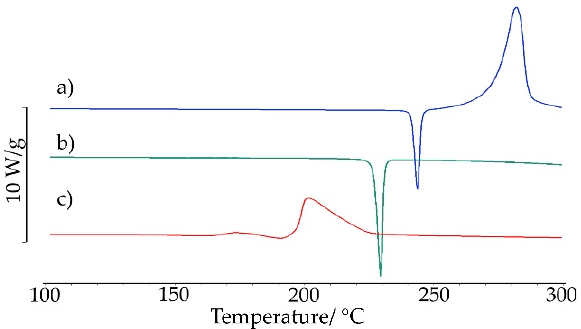
Figure 6. DSC curves for: ( a ) chlordiazepoxide, ( b ) saccharin, and ( c ) chlordiazepoxide mixture with saccharin. Measurements were taken at a heating rate of 10 °C/min in nitrogen.